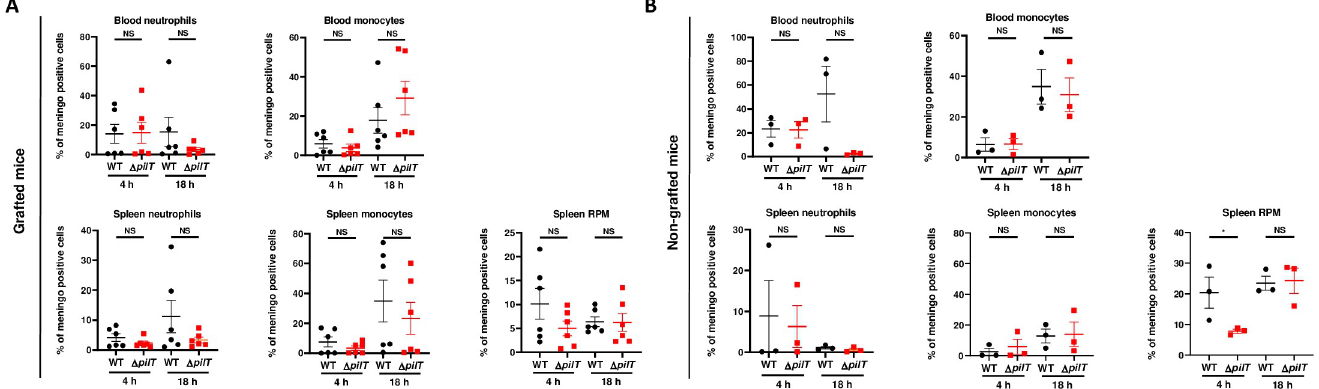
Fig 4. N . meningitidis WT and Δ pilT are similarly phagocytized. (A, B ) N . meningitidis phagocytosis at 4 h and 18 h PI in the blood or spleen of grafted (A) and non-grafted (B) SCID mice. Neutrophils were identified as CD11b + Ly6G hi . Red pulp macrophages (RPM) were identified as CD11b neg F4/80 hi and proinflammatory monocytes were identified as CD11b + Ly6G − Ly6C hi F4/80 + . Two independent experiments for grafted mice with n = 6 mice in each group (B) and one experiment for non-grafted mice with n = 3 mice in each group (A). Bars represent mean ± SEM, NS p > 0.05; � p < 0.05, one-way ANOVA followed by multiple comparison test.